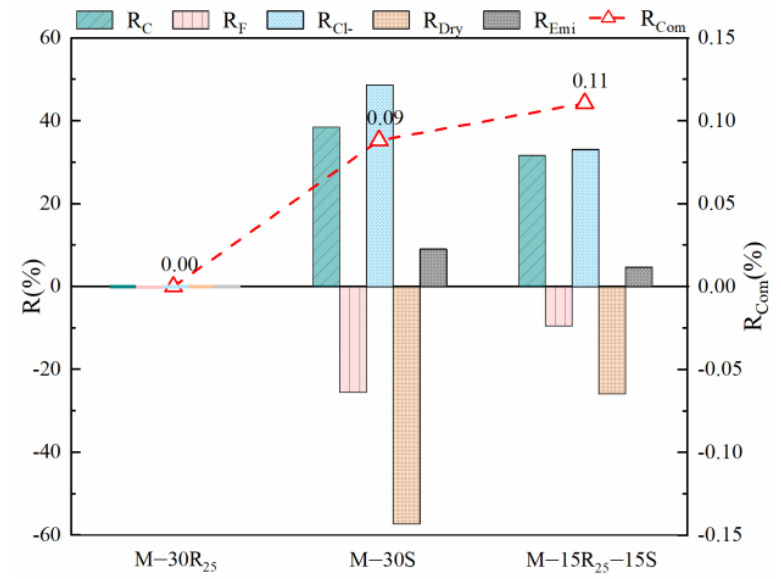
Figure 9. Fundamental properties of eco-efficient mortar in Series A.